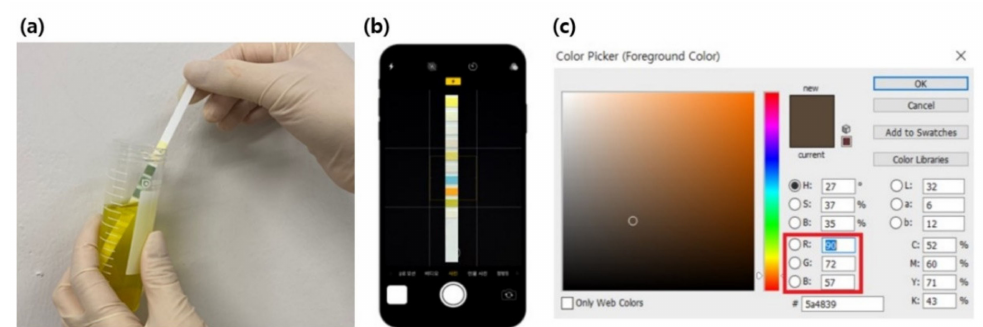
Figure 2. RGB extraction process for the urine dipstick. ( a ) The step where a dipstick was dipped into an artificial urine sample containing analytes. ( b ) The step where a dipstick was taken with the smartphone. ( c ) The step of extracting RGB values from the color pad of the